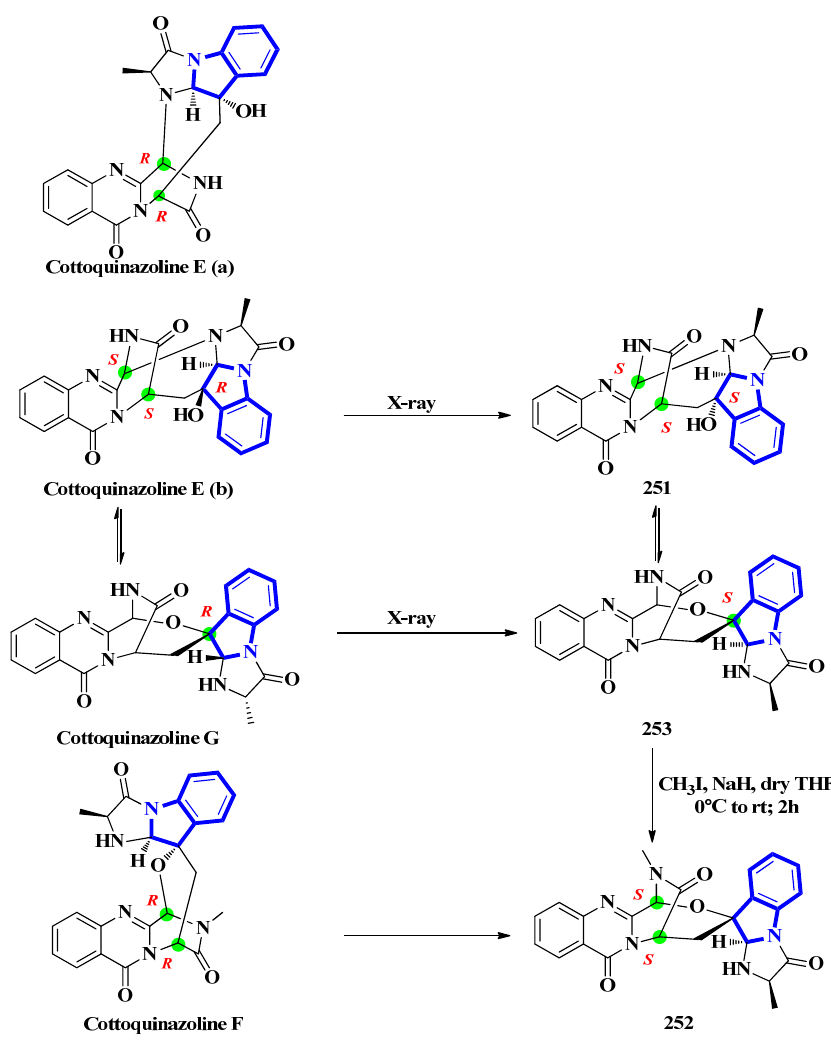
Figure 12. Reappraised structures of cottoquinazolines (E–G) 251–253 . Echinosulfone A ( 254 ) and echinosulfonic acids A–C ( 255–257 ) were initially isolated from Echinodictyum , a marine sponge [75]. Similarly, echinosulfonic acid D ( 258 ) was isolated from a Psammoclema sponge, and its structure was assigned on the basis of the previous report [76]. However, discrepancies arose when decomposition products of 254 were analyzed using X-ray diffraction. Thus, the original alkaloids were reisolated from sponges in the Crella genus. Their structures were re-evaluated using 1D and 2D NMR data in conjunction with MS fragmentation, X-ray crystallography, and DFT predictions of 13 C-NMR shifts. For compound 254 , the original sulfonyl bridge between the two indole monomers was modified to a carbonyl bridge, while the N-1-bonded carboxylic acid was replaced with an N-1-bonded sulfonic acid (Figure 11). Similar changes were made in compounds 255 to 258 , where the C1 (cid:48)(cid:48) -bonded sulfonic acid was changed with the C1 (cid:48)(cid:48) - bonded methoxycarbonyl group. The N-1-bonded methoxycarbonyl was replaced with an N-1-bonded sulfonic acid moiety (Figure 13)